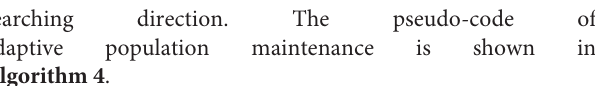
searching direction. The pseudo-code of adaptive population maintenance is shown in Algorithm 4